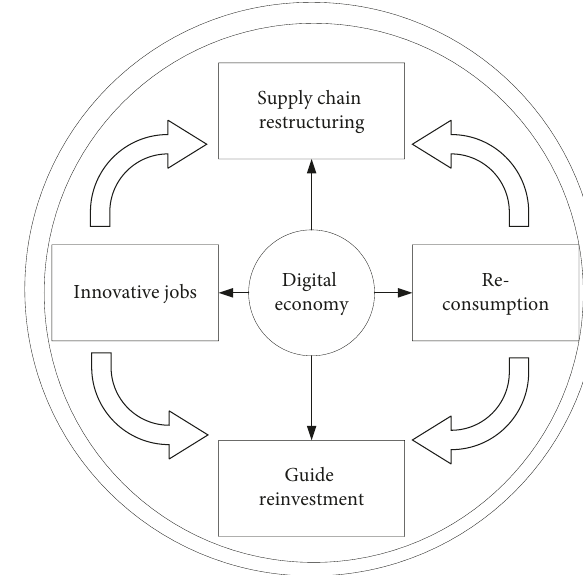
Figure 6: Circular sustainable development of the digital economy.